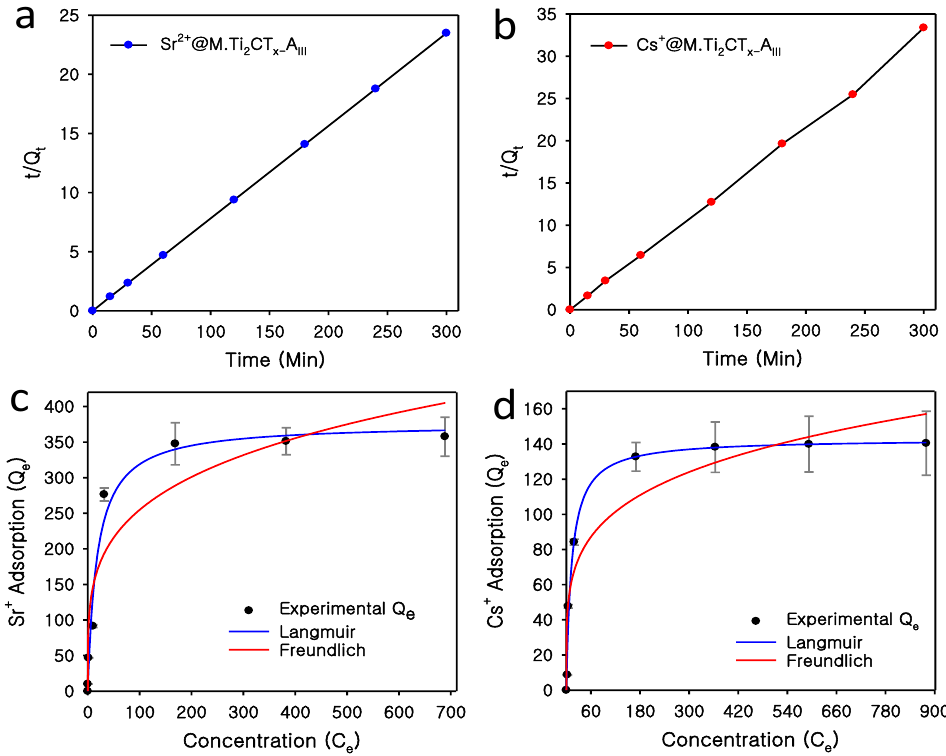
Figure 5. Adsorption kinetics: pseudo-second-order kinetics graphs of ( a ) Sr 2+ @ M.Ti 2 CT x -A III and ( b ) Cs + @ M.Ti 2 CT x -A III . Langmuir and Freundlich adsorption isotherm model graphs of ( c ) Sr 2+ and ( d ) Cs + adsorbed by M.Ti 2 CT x -A III . Table 4. Langmuir and Freundlich adsorption isotherm parameters for Sr 2+ and Cs + adsorption on M.Ti 2 CT x -A III.